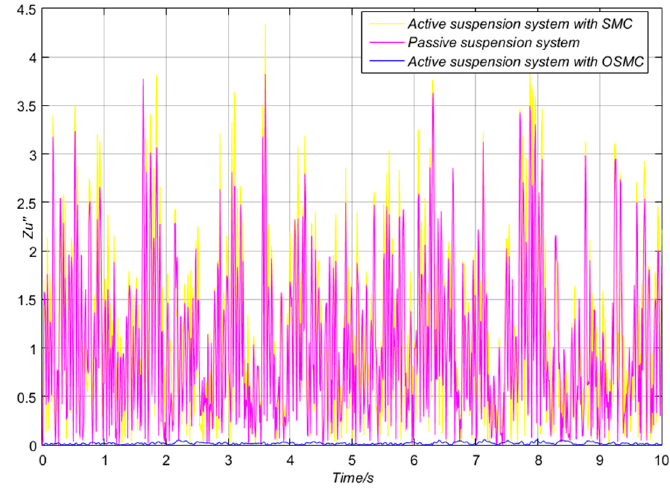
Figure 9. Comparison of the three suspension systems’ vertical acceleration.